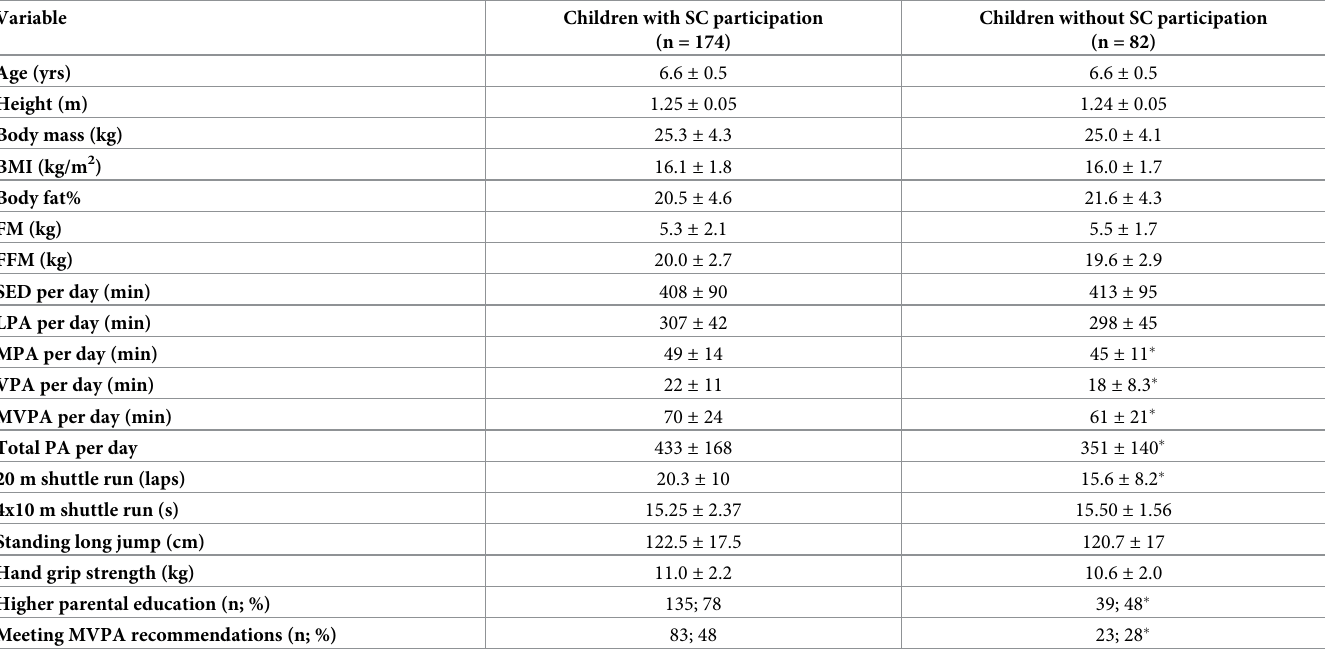
Table 2. Differences in body composition, physical activity and fitness according to children‘s participation in sports club